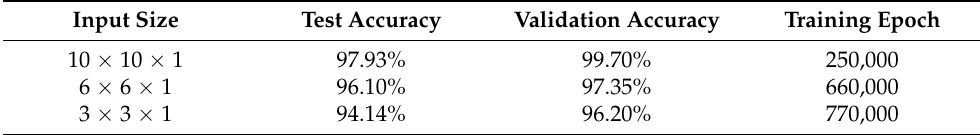
Table 5. Test accuracy results for TDK IMU